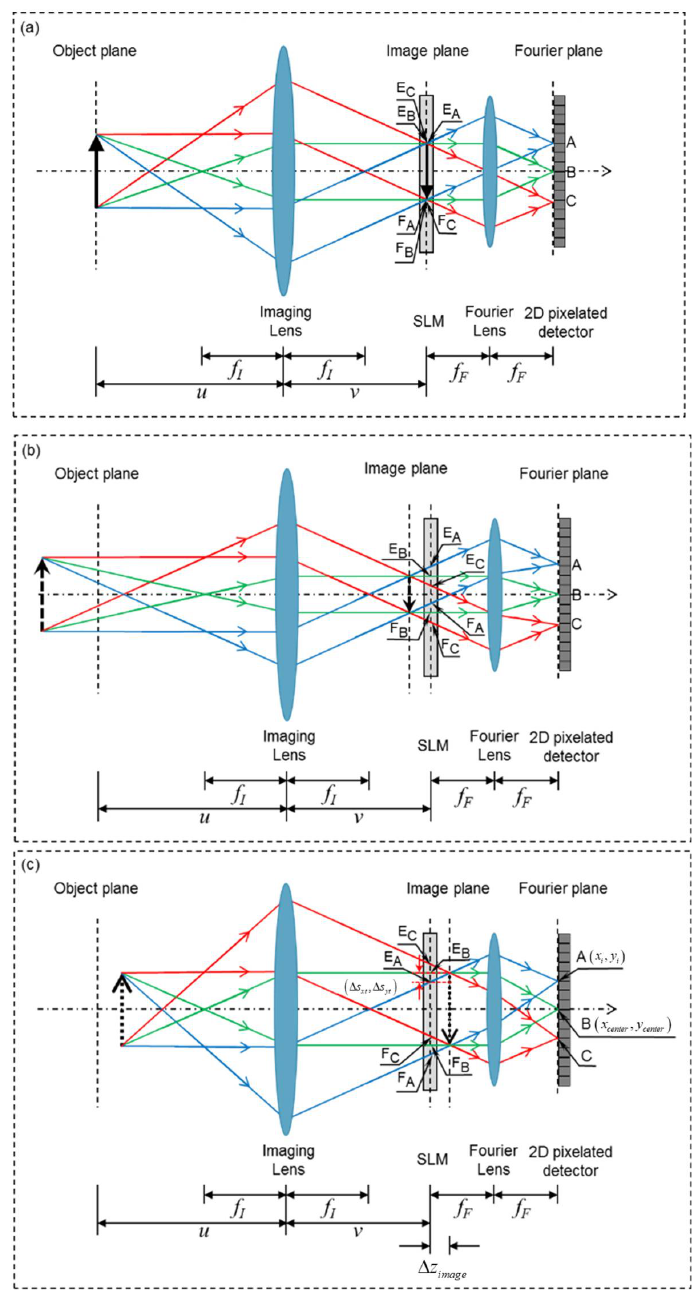
Figure 4. The principle that depth information of objects is recorded by the FRLFC. ( a ) The object is at the object plane. ( b ) The object is in front of the object plane. ( c ) The object is behind the object plane. A, B, and C represent three different pixels of the 2D detector; u and v represent object distance and image distance, respectively; f I and f F represent the focal length of the imaging lens and the Fourier lens, respectively; E A F A , E B F B and E C F C represent the spatial coordinate range of the images reconstructed by pixels A, B, and C, respectively.